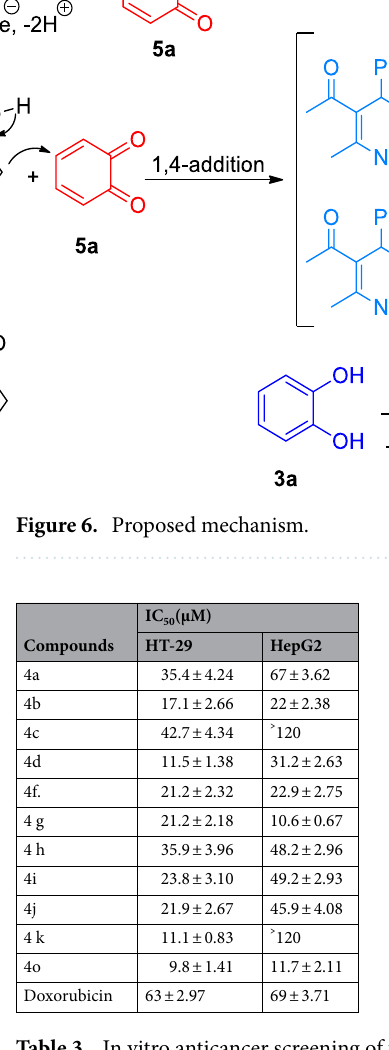
Table 3. In vitro anticancer screening of the compounds against HT(29) and HepG2 cancer cells expressed as IC 50 values